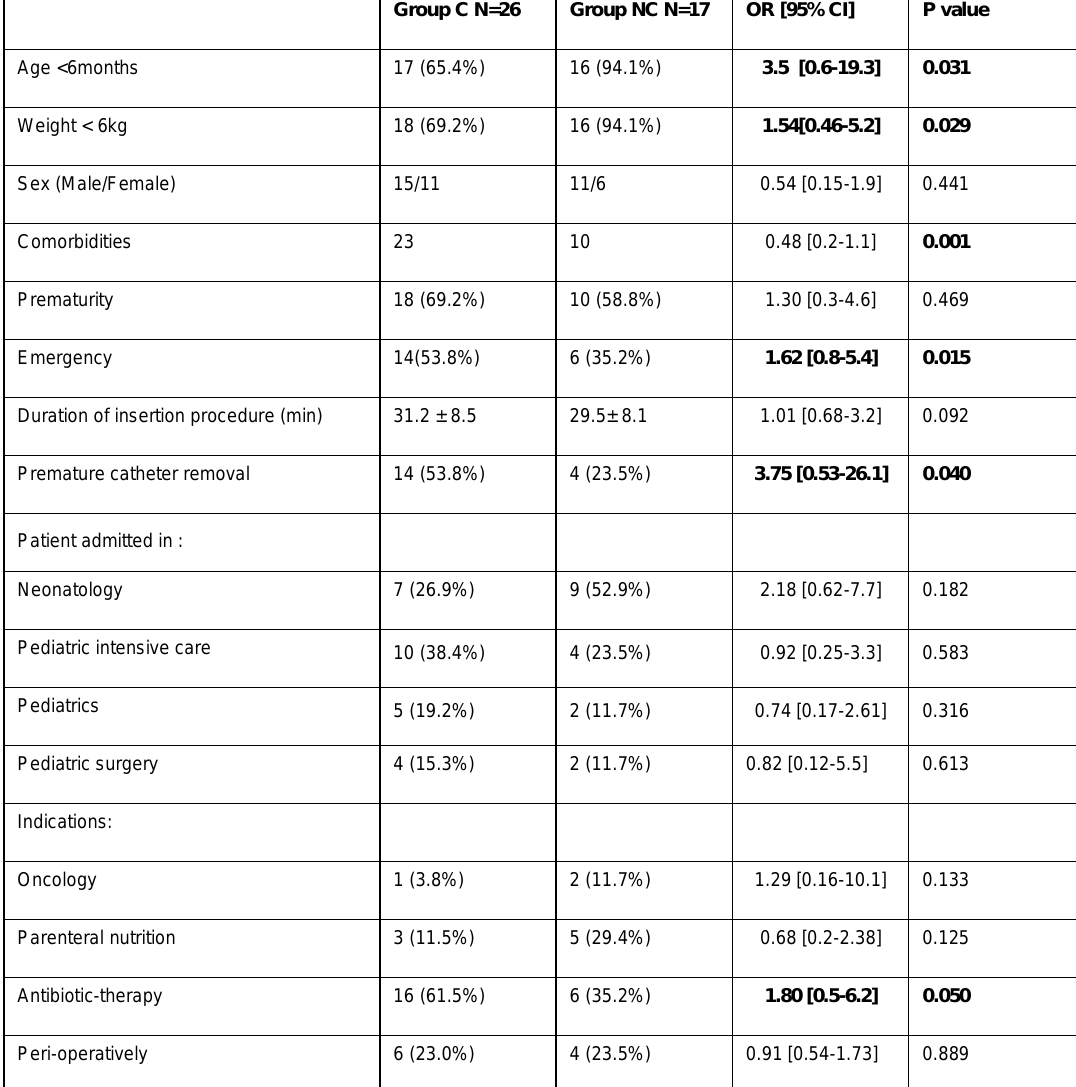
Table 1: Risk factors for Broviac catheter